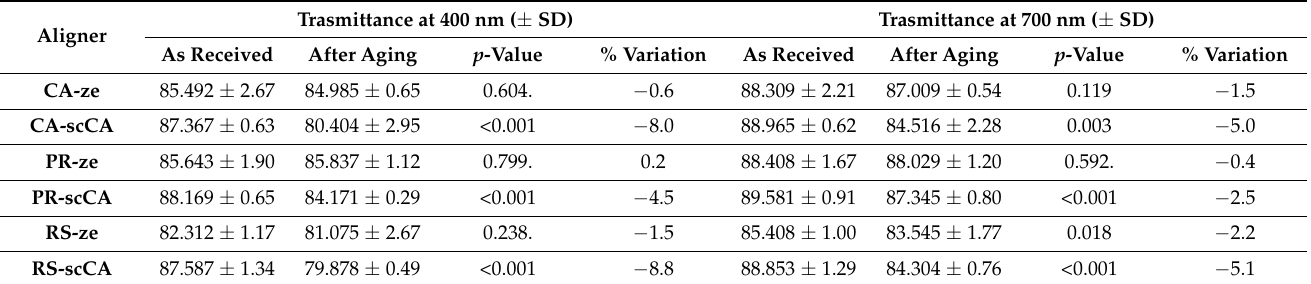
Table 1. Transmittance values of six type of aligners before and after in vitro aging. The data are the average of nine values ± SD. High significance level ( p <